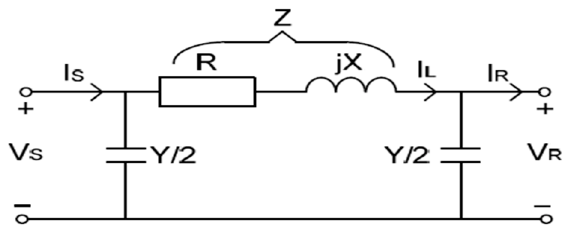
Figure 11. Medium-length line model.